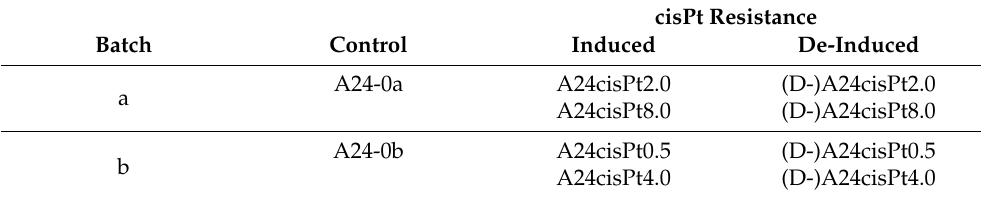
Table 1. Cell sample groups and their labels included in the